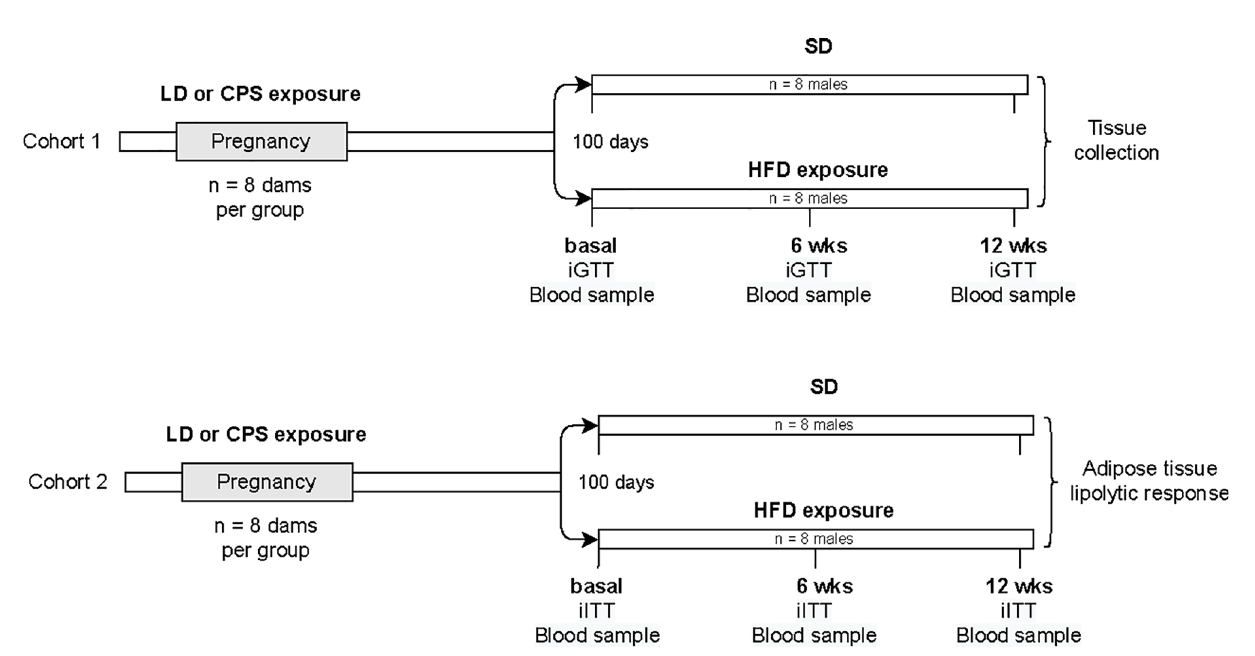
FIGURE 1 | Flow diagram of experimental protocol. Pregnant rats were exposed to either control photoperiod (LD) or chronic photoperiod shift (CPS) from mating until 18 days of gestation. At 100 days old, male offspring were exposed to either high-fat diet (HFD; 45% excess calories) or standard diet (SD) for 12 weeks (about 200 days old). iGTT, intraperitoneal glucose tolerance test; iITT, intraperitoneal insulin tolerance test; n = number of